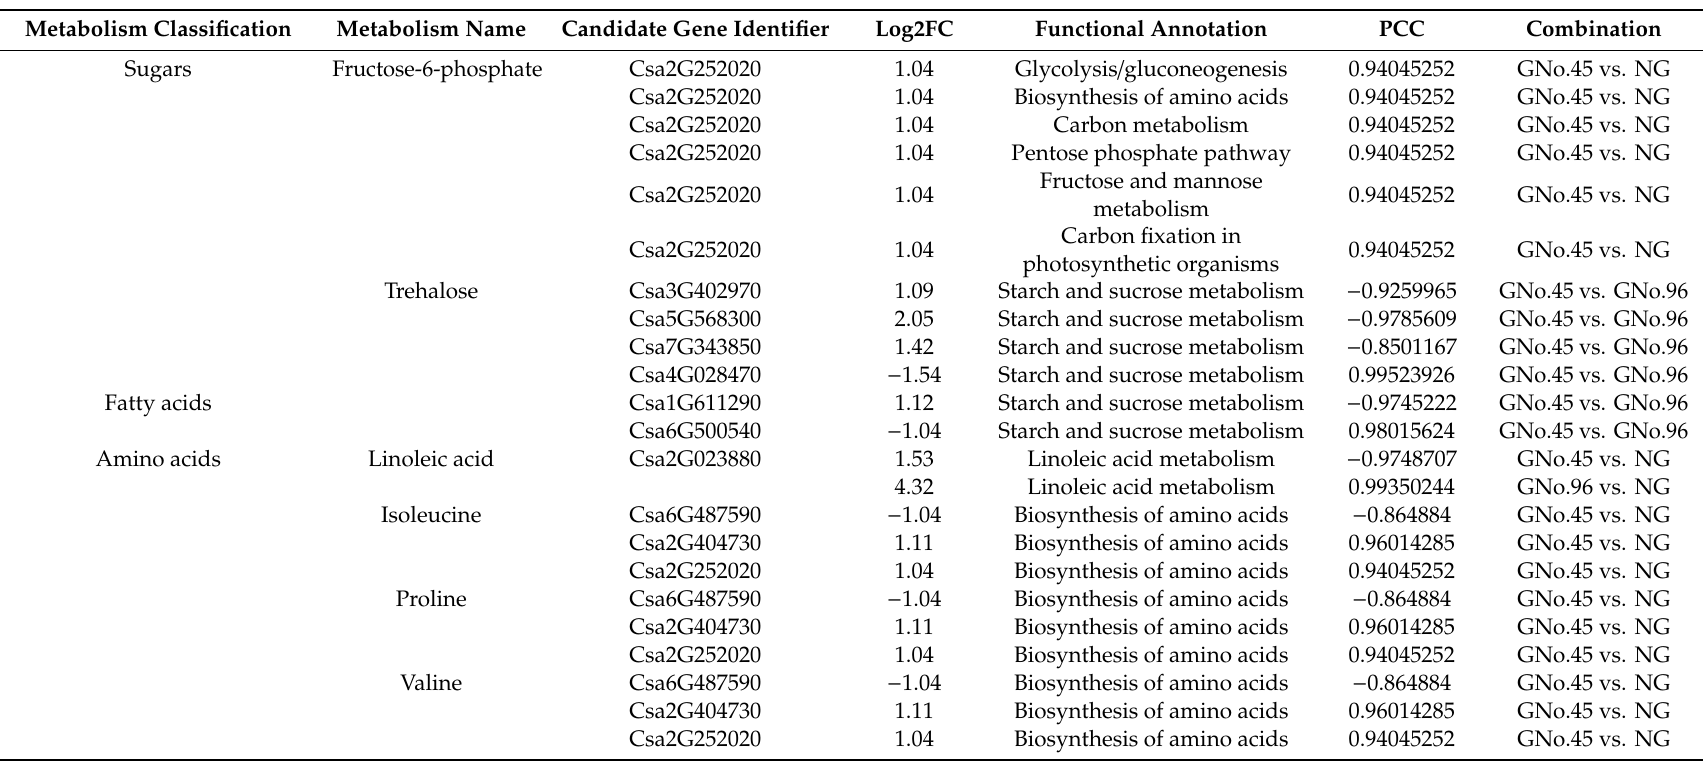
Table 1. Representative candidate genes determined by di ff erent metabolites (DMs)-gene Pearson correlation analysis, which are likely involved in grafted cucumber fruit flavor. NG—non-grafted